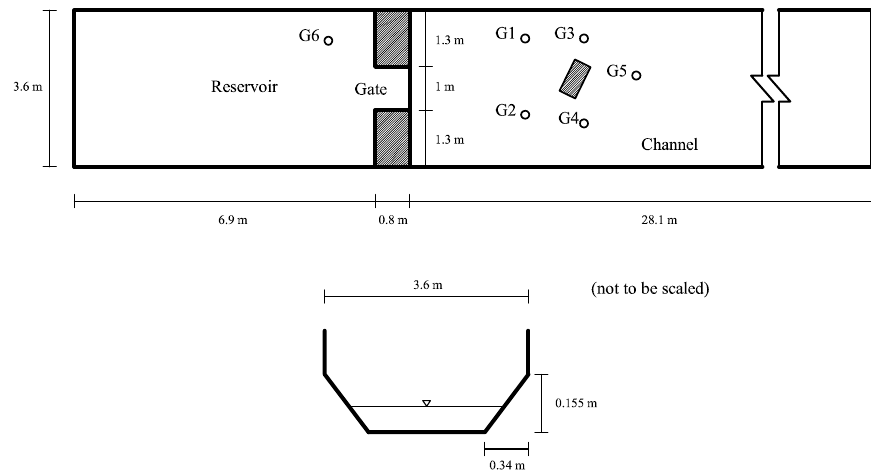
Figure 8. Case 2: sketch of domain and channel